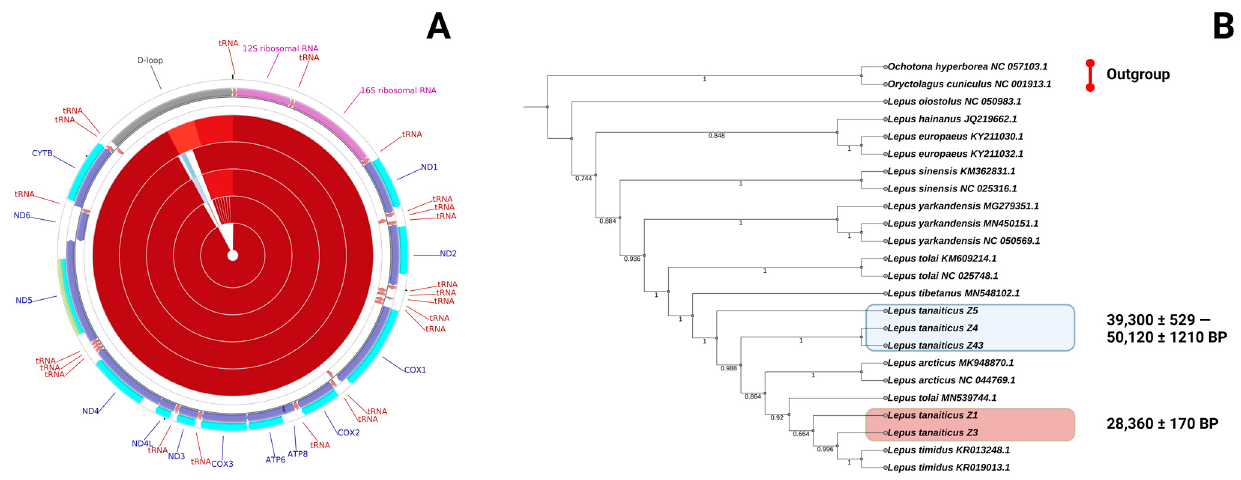
Figure 3. The mitochondrial genomes of Pleistocene Don-hare. ( A ) Circular representation of the L. tanaiticus mitochondrial genomes (specimens Z1, Z3, Z4, Z43 and Z5). Genes encoded by the heavy (H) strand are shown outside and those encoded by the light (L) strand are shown inside the mitogenome. Different genes are shown as filled boxes in different colours. ( B ) Parsimony phylogenetic tree of Lepus species, including the “young” (marked by the red box) and “old” (marked by the blue box) L. tanaiticus specimens, based on their mitochondrial DNA sequences. Bootstrap values are shown in the nodes of phylogenetic